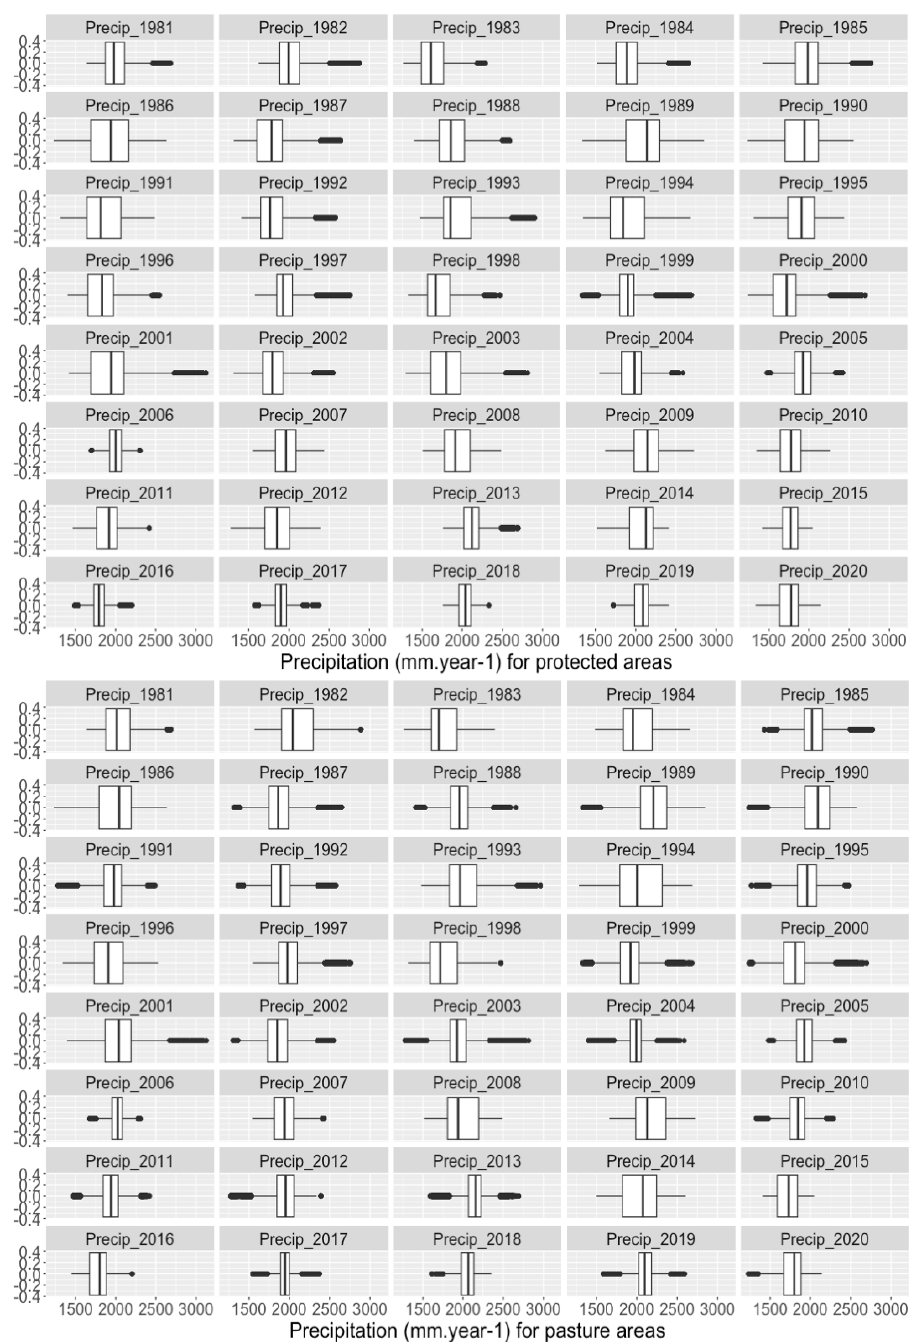
Figure 4. Precipitation distribution (mm.year − 1 ) for protected areas and pasturelands for years from 1981 to 2020 using CHIRPS data.